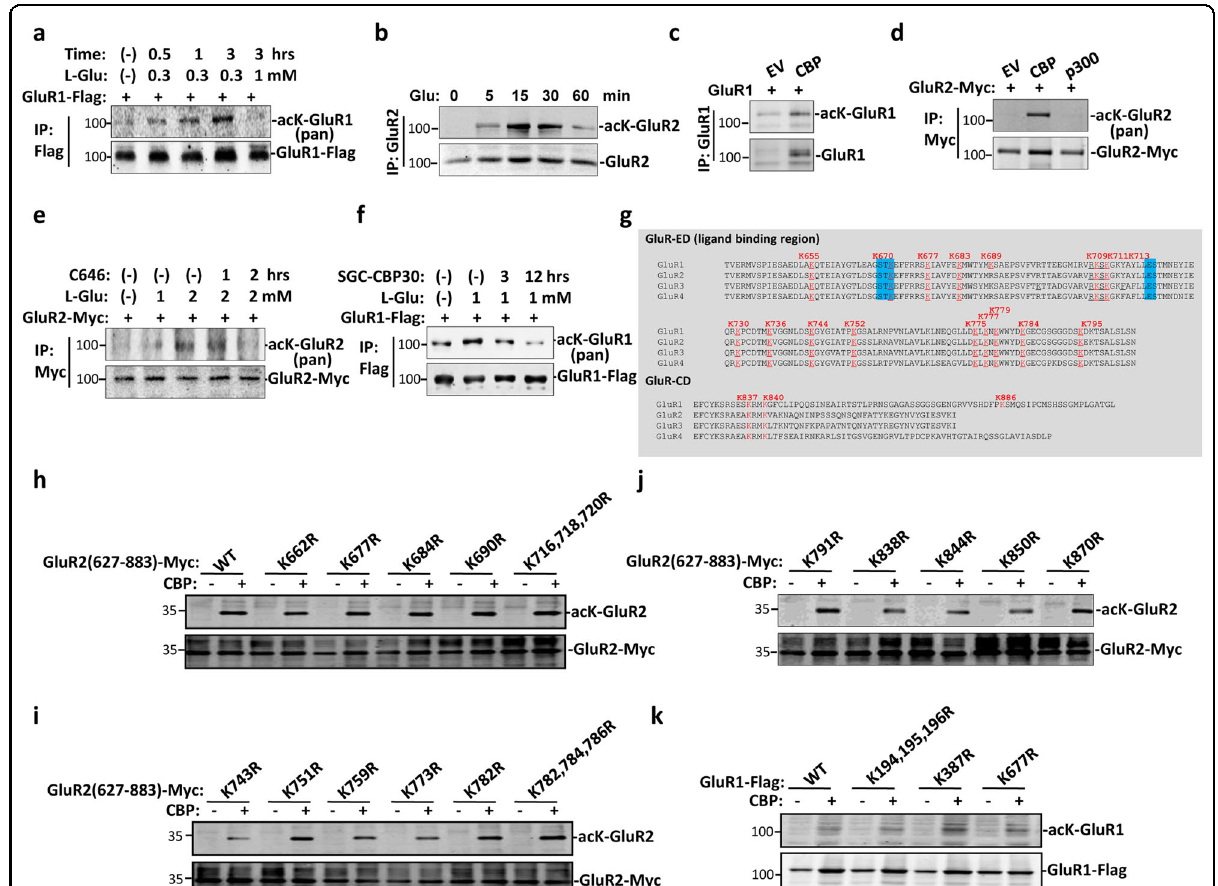
Fig. 1 GluR1 and 2 are acetylated by CBP upon glutamate treatment. a 293 T cells were transfected with Flag-GluR1 and then were treated with glutamate for different time. Cells were subjected to immunoprecipitation with Flag antibody followed by western blot with pan-acetyl and Flag antibodies. Data shown are representative of three independent experiments. b C6 cells were treated with glutamate for different time. Cells were subjected to immunoprecipitation with GluR2 antibody followed by western blot with pan-acetyl and GluR2 antibodies. c 293 T cells were either transfected with GluR1 and CBP or GluR1 alone. Cells were subjected to immunoprecipitation with GluR1 antibody followed by western blot with pan-acetyl and GluR1 antibodies. d 293 T cells were transfected with indicated plasmids. Cells were subjected to immunoprecipitation with Myc antibody followed by western blot with pan-acetyl and Myc antibodies. e 293 T cells were transfected with Myc-GluR2 and then were treated with glutamate and CBP inhibitor (C646) for different time. Cells were subjected to immunoprecipitation with Myc antibody followed by western blot with pan-acetyl and Myc antibodies. Data shown are representative of two independent experiments. f Alignment of C-terminal region of GluRs family. g Schematic show of GluR1 structure and possible sites of acetylation. h – k Mapping of acetylation sites in GluR1 and GluR2 by mutation